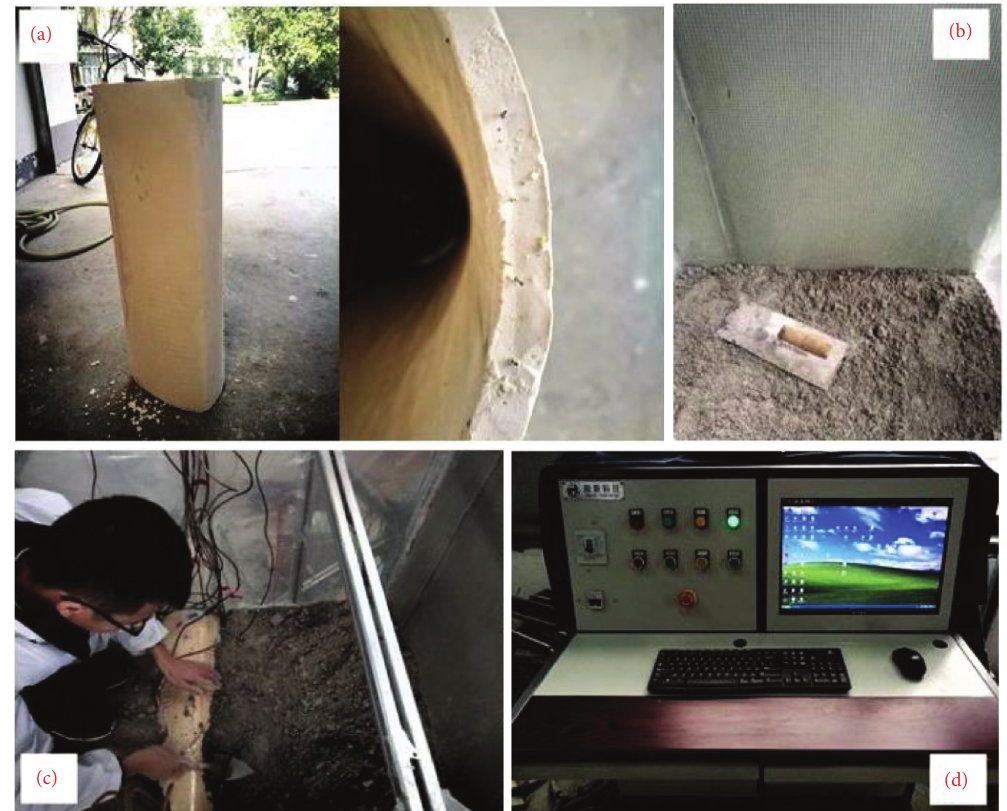
Figure 4: Model test setup. (a) Lining model. (b) Smoothing of lining. (c) Pouring surrounding rock. (d) Test operating platform.